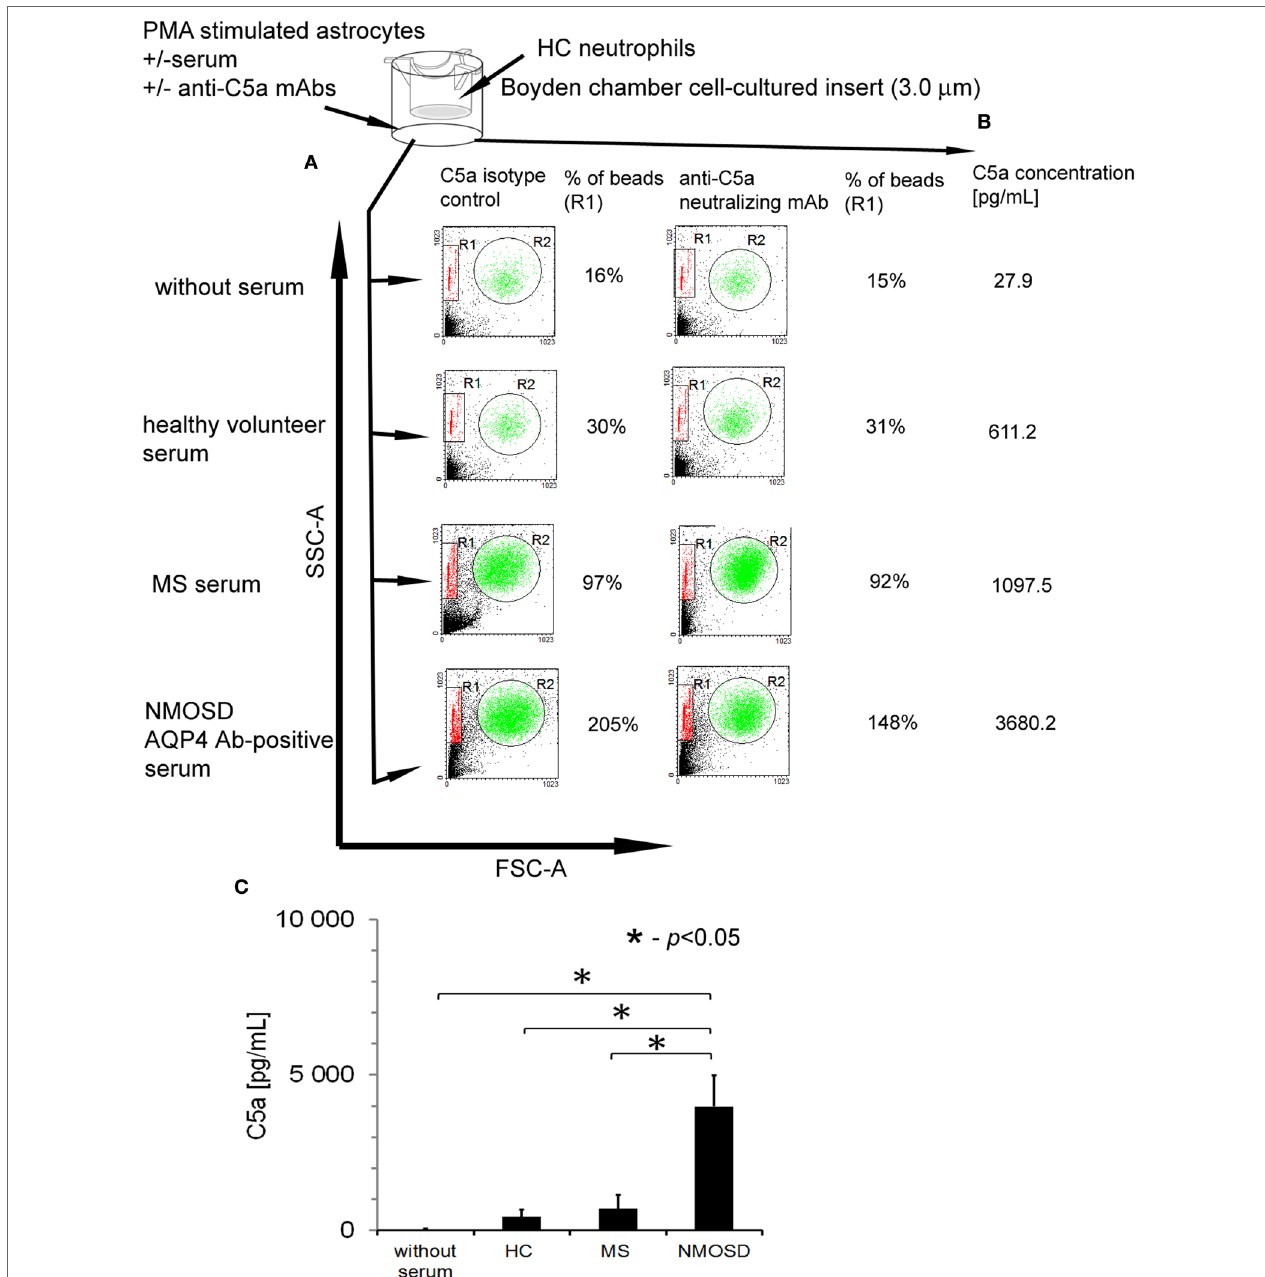
FigUre 4 | Human astrocytes recruit healthy control (HC) neutrophils in the presence of anti-aquaporin-4 (AQP4) Ab-positive neuromyelitis optica spectrum disorder (NMOSD) serum as a result of C5a release. (a) Astrocytes preincubated with NMOSD serum induce chemotaxis of HC neutrophils as the result of C5a release. The example of analysis representative of four independent experiments. R1—region of beads; R2—region of neutrophils. (b) C5a release following AQP4–IgG1 binding to AQP4 during incubation of primary human astrocytes with NMOSD serum. Concentration of C5a was measured in supernatants after 1 h incubation with NMOSD, remitting–relapsing multiple sclerosis, or HC serum. (c) Concentration of C5a in supernatants of astrocytes incubated with NMOSD or control serum. The bars represent the means ± SD from four independent